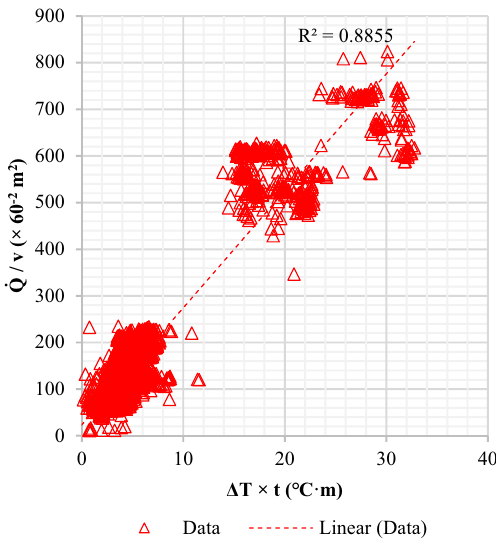
Figure 10. Plot of quenching characteristics using combined